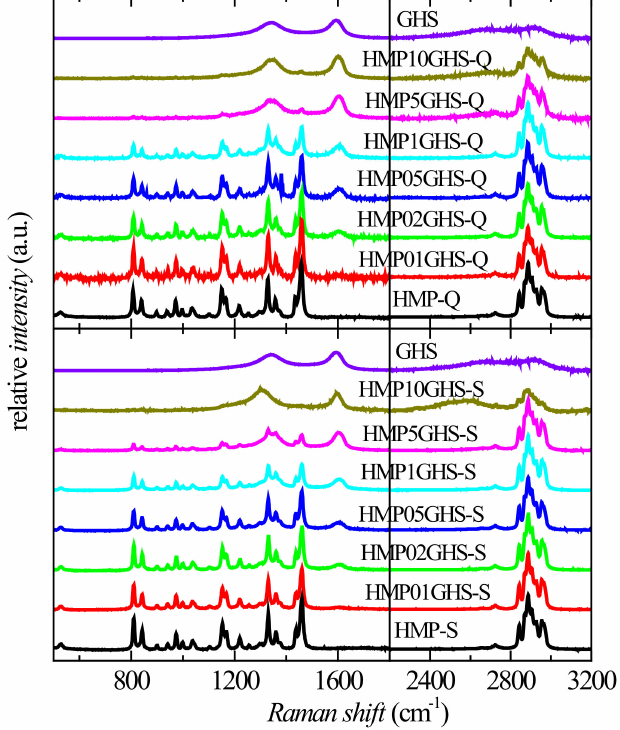
Figure 4. Raman spectra for the HMP x GHS nanocomposites under the Q and S thermal